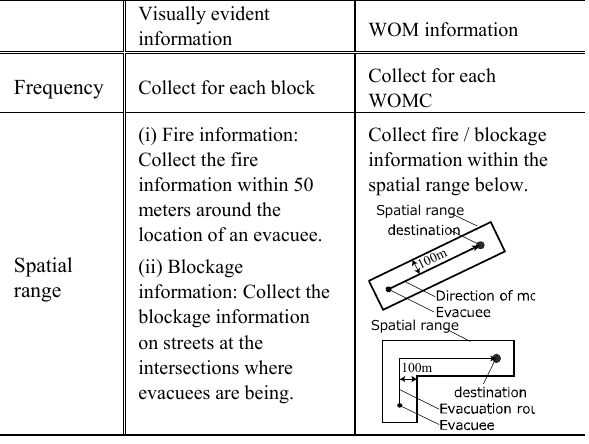
Table 2. Frequency and spatial range of disaster information